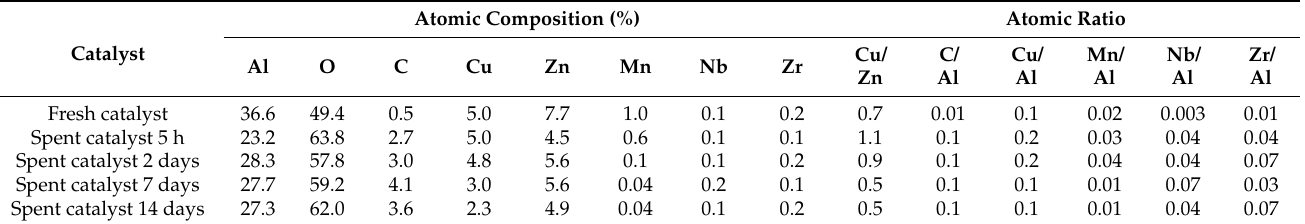
Table 8. Surface atomic